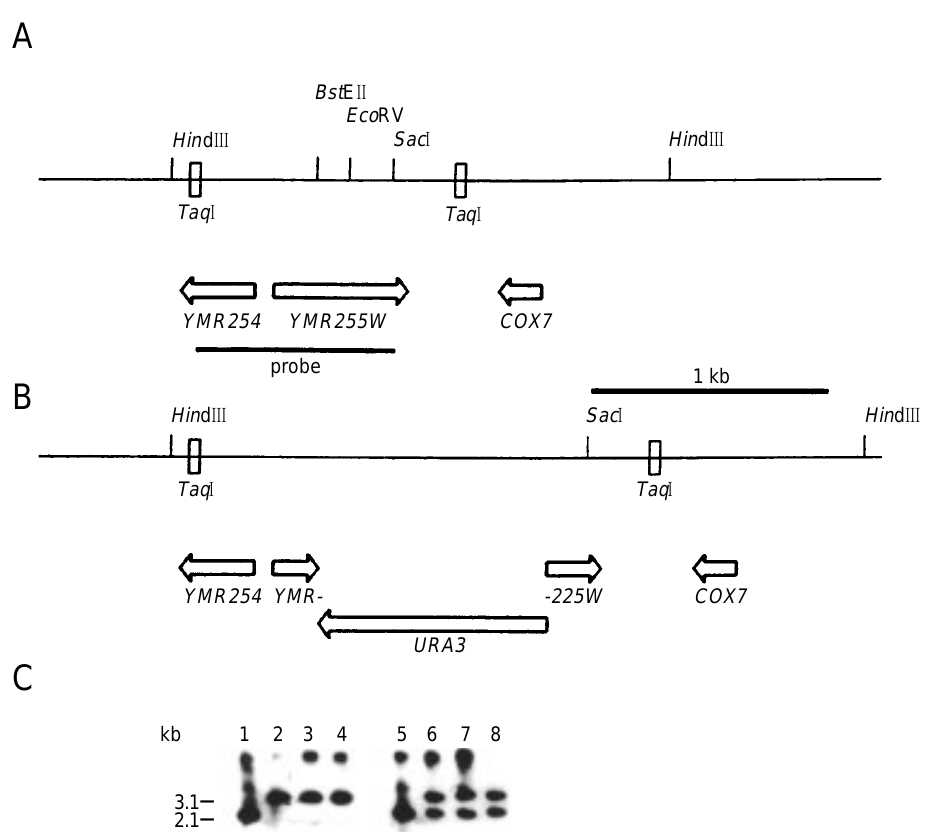
Figure 3 - Southern hybridiza- tion analysis of yeast genomic DNA from representative iso- lates of strain W303 after dis- ruption of YMR255W. The loca- tion of the restriction sites is marked along the line that rep- resents the DNA. The ORFs and respective orientations are shown below. A, Map of the YMR255W region indicating the BstE II and EcoRV sites used to delete a 137-bp internal frag- ment of the gene before the in- sertion of a 1166-bp DNA frag- ment carrying the URA3 gene. B, Map of the same chromo- somal region after gene replace- ment with the construction ex- plained above. C, Electrophore- togram of total yeast DNA pre- pared from the control strain W303-1A (lanes 1 and 5) or from individual transformants from experiments done with the W303-1A haploid strain (lanes 2, 3 and 4) or with the diploid W303 strain (lanes 6, 7 and 8). About 0.2 µg of DNA was di- gested with Hind III , fraction- ated by electrophoresis on 1% agarose gel and blotted onto Hybond N. The Southern blot was hybridized to the labeled Taq I -Sac I fragment (probe) and exposed to X-ray film. The size of the fragments detected is in- dicated on the left-hand margin. this study was respiratory incompetence.